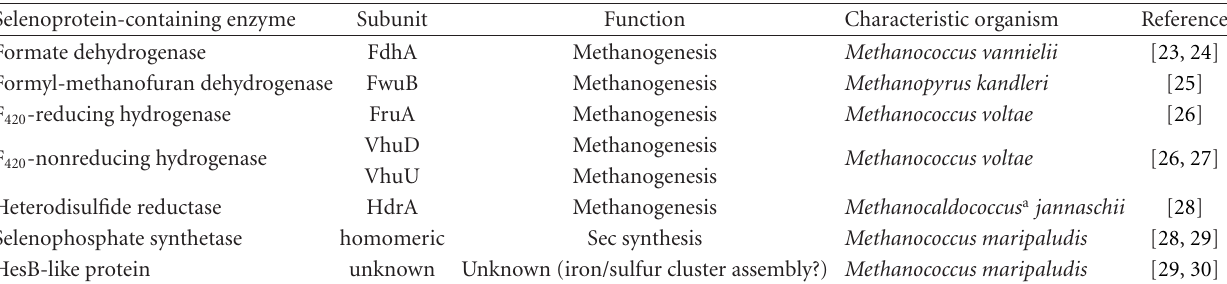
Table 1: Sec-containing proteins of archaea.